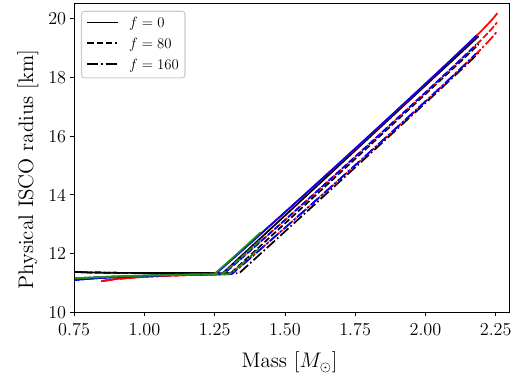
Fig. 12 ISCO radius as a function of the gravitational mass for GR and TMST with the monotonic coupling function (12), for n = 1 and different β values. Solid lines denote static configuration while dashed and dash-dotted lines correspond to the f = 80 Hz and f = 160 Hz cases. Color scheme follows Fig. 9